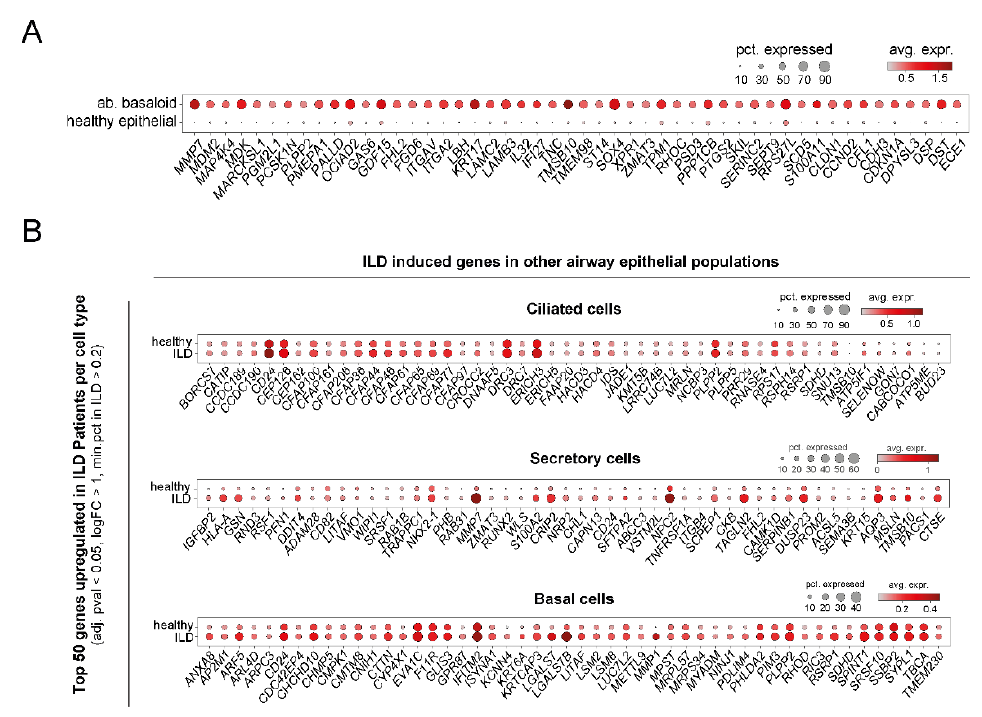
Figure 5. Epithelial cell populations show distinct expression changes in ILD. Using the data set described in Figure 3, differential gene expression analysis was performed with diffxpy (https://github.com/theislab/diffxpy, last accessed 22 December 2021) while accounting for number of transcripts per cell and patient cohort. The top 50 deregulated genes in specific subpopulations of epithelial cells are given, ranked by log2 fold change. ( A ) Top 50 genes induced in aberrant basaloid cells relative to gene expression of all other healthy epithelial cell types. ( B ) Top 50 genes increased in ILD in other airway epithelial cell populations. pct., percentage; avg. expr., average expression; ab., aberrant.